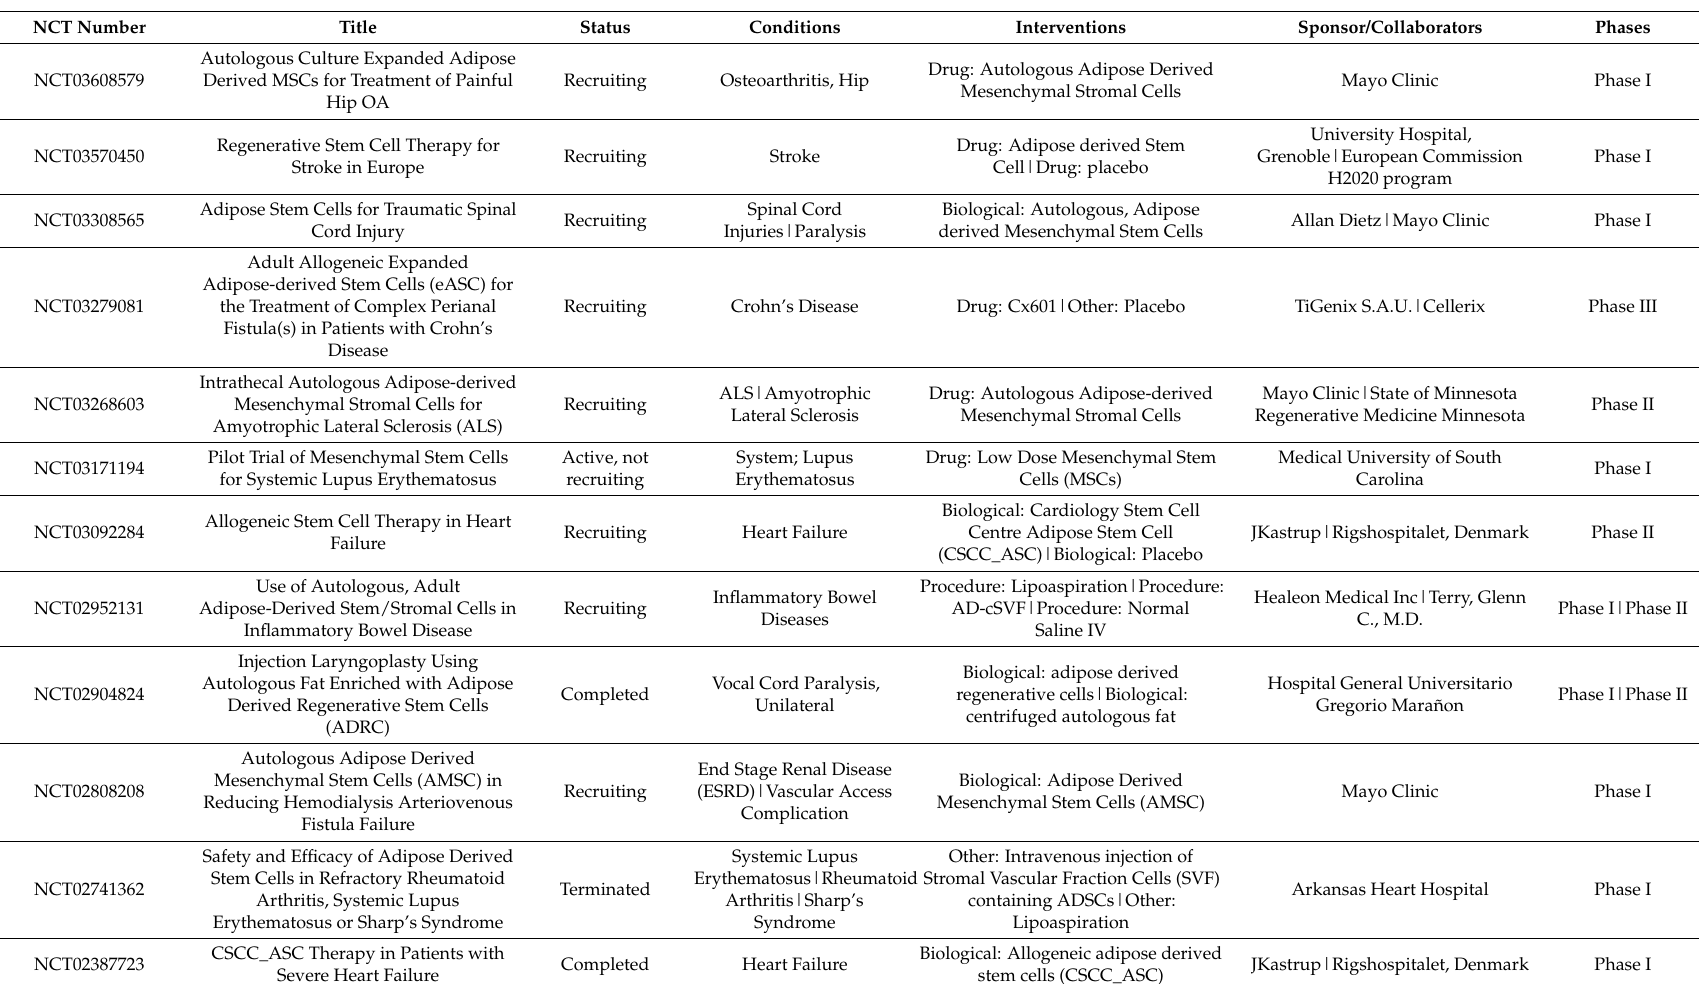
Table 2. Clinical trials. The table reports registered clinical trials on https://clinicaltrials.gov focused on adipose stem